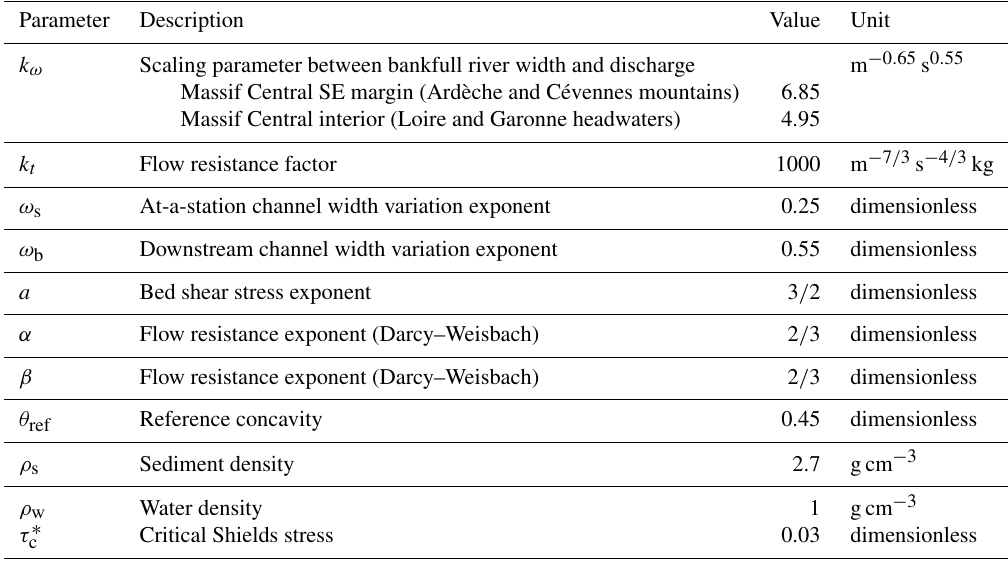
Table 1. Reference parameters used in the modeling.